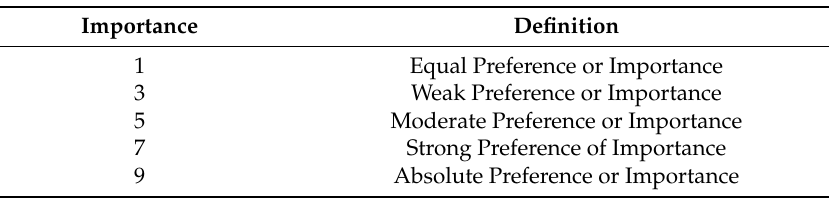
Table 1. Saaty’s Fundamental Scale 1 .